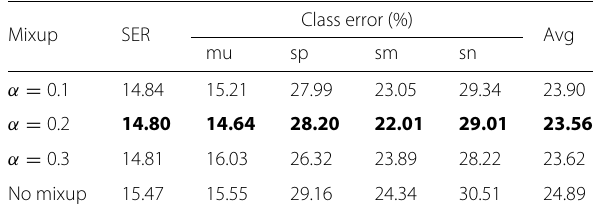
Table 8 SER, error per class and average class error on the test